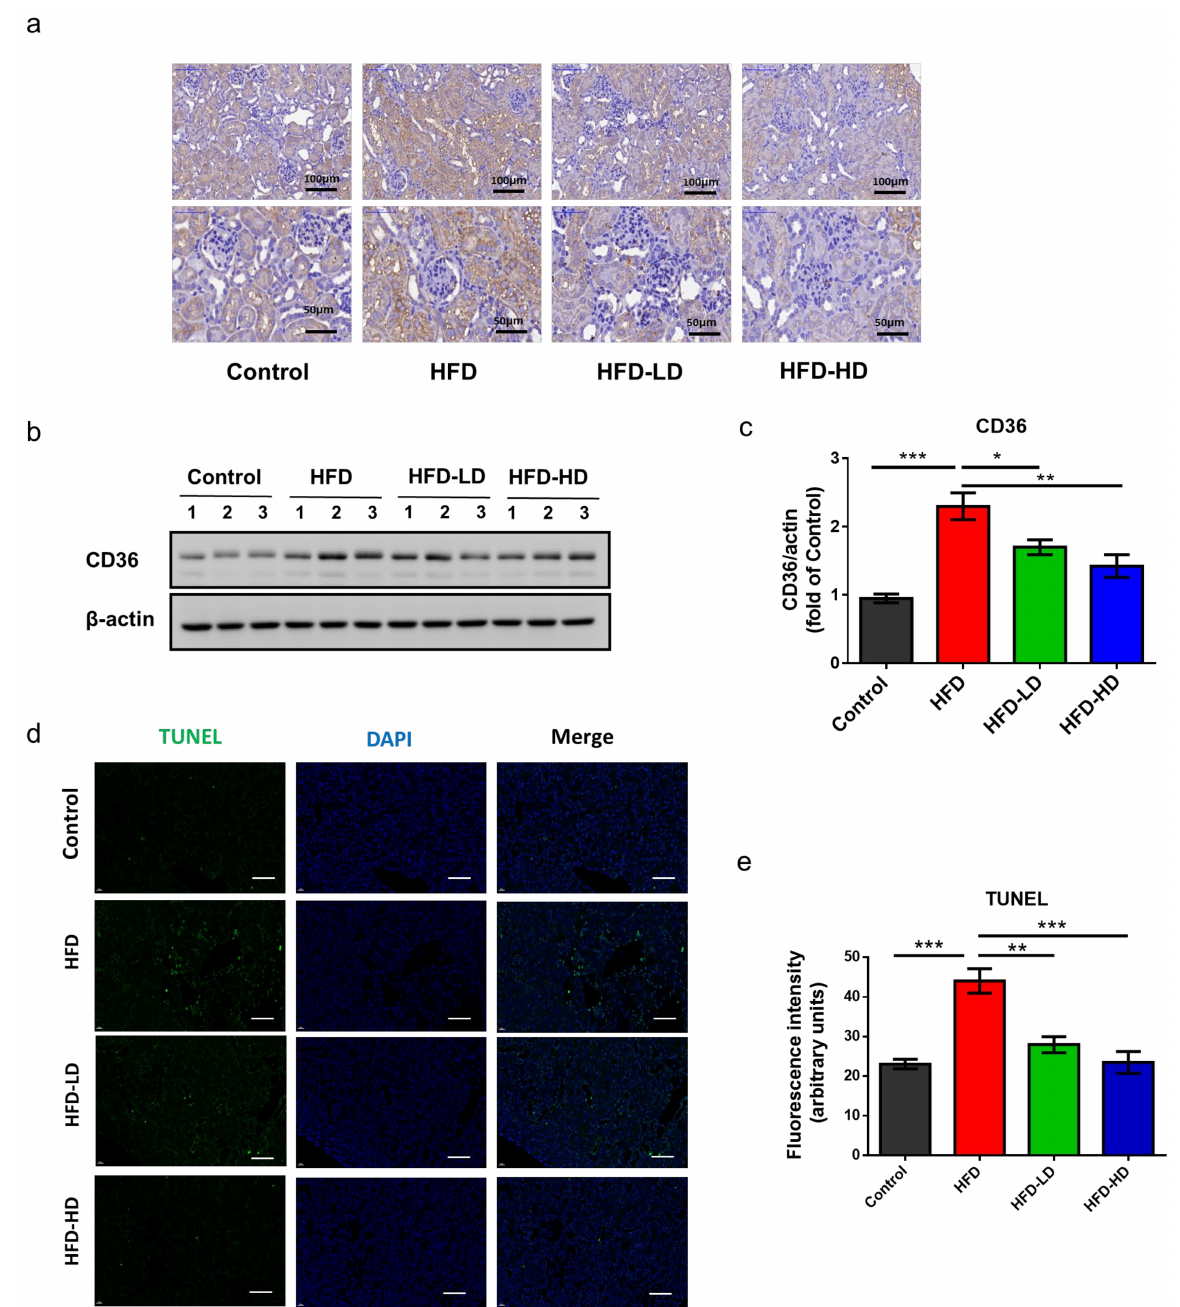
Figure 3. Empagliflozin attenuates CD36 expression in the kidney of HFD mice ( n = 6). Empagliflozin attenuates CD36 expression in the HFD group, as shown by ( a ) immunohistochemical staining and ( b , c ) Western blotting. ( d , e ) Representative images and quantitative results of TUNEL staining show that empagliflozin attenuates cell apoptosis (green color) in a dose-dependent manner (scale bars = 50 µ m). The histograms represent mean ± standard error (SE). Statistical analysis was performed with one-way ANOVA. * p < 0.05, ** p < 0.01, *** p < 0.001 vs. HFD in each group. HFD, high-fat diet; LD, low-dose empagliflozin; HD, high-dose